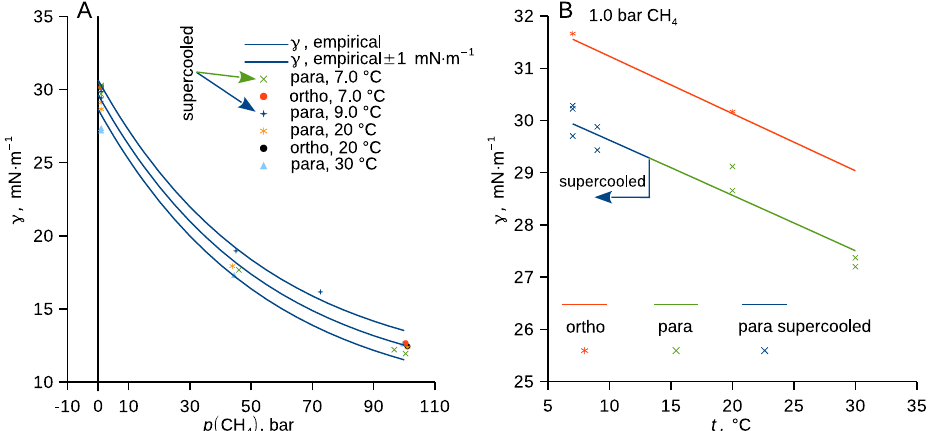
Figure 4. ( A ) Surface tension of p -xylene ( p -C 8 D 10 ) and o -xylene ( o -C 8 D 10 ) plotted against methane pressure and ( B ) against temperature for a fixed (atmospheric) pressure. Typical uncertainty of surface tension due to random errors ( u r , cover factor 2) is 1–2 mN ⋅ m −1 ; experimental data are in Table S3 in SI. Curves represent guides for the eye ( A ) and correlations for protium-based xylenes taken from the database 12 ; the blue part of the curve is the extrapolation for the supercooled liquid at 1.0 bar ( B